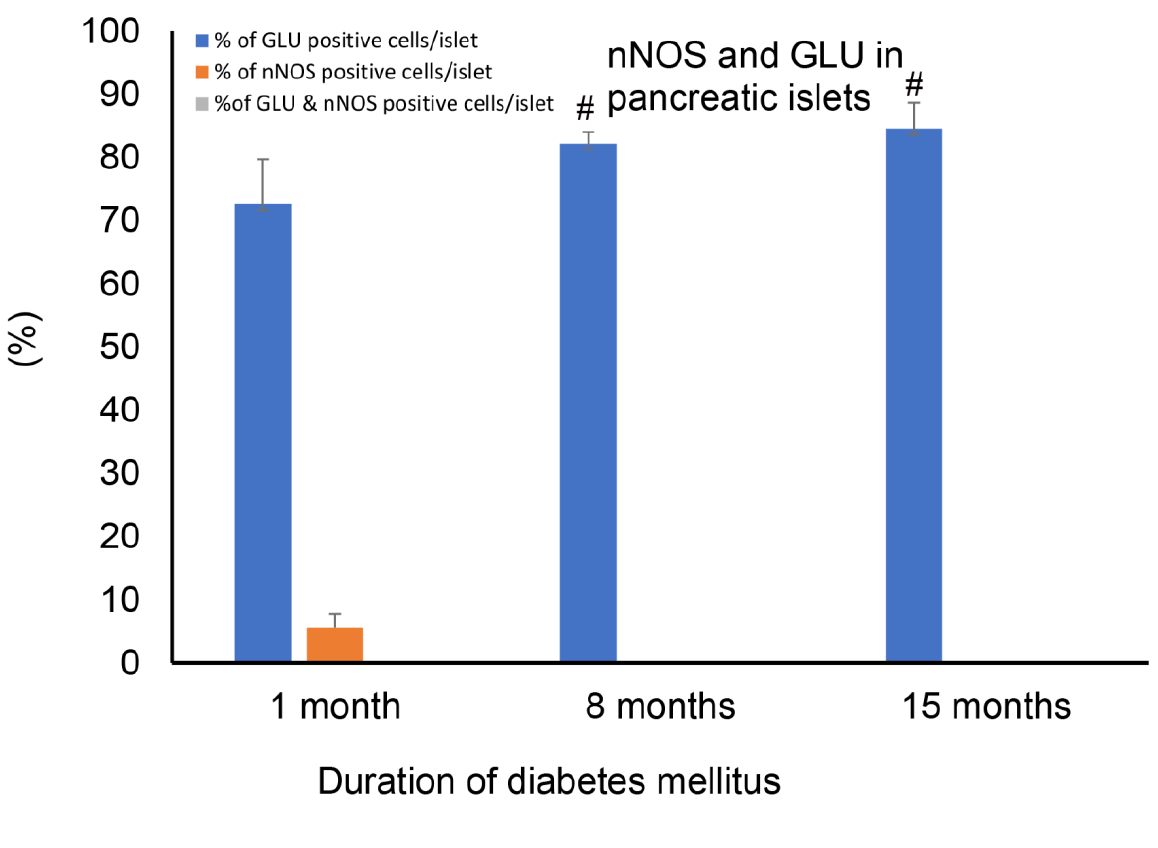
Figure 8. ( a ) shows glucagon (GLU)-(green) and nNOS-(red)-immuno-positive cells in pancreatic islets of rats 1, 8 and 15 months after the induction of diabetes. There was no co-localization between glucagon and nNOS. nNOS-immunoreactive ganglion cell (arrow) and varicose nerve fibres (arrow head) were observed in the exocrine pancreas. Fragments of nNOS-positive cells were observed in the islet 1 months after the onset of diabetes. Scale bar = 10 μm. ( b ) shows morphometric analysis of the glucagon-positive cells in the islet cells of the endocrine pancreas. Note the significant (# p < 0.01) increase in the number of glucagon-positive cells 8 and 15 months after the induction of diabetes. (n = 6).